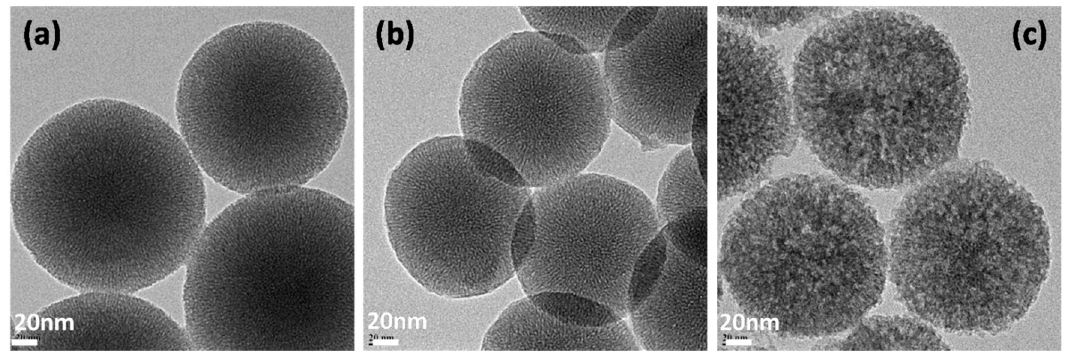
Figure 1. Transmission electron microscopy (TEM) images of ( a ) MSN, ( b ) MSN-NH 2 and ( c ) MSN- CMC.